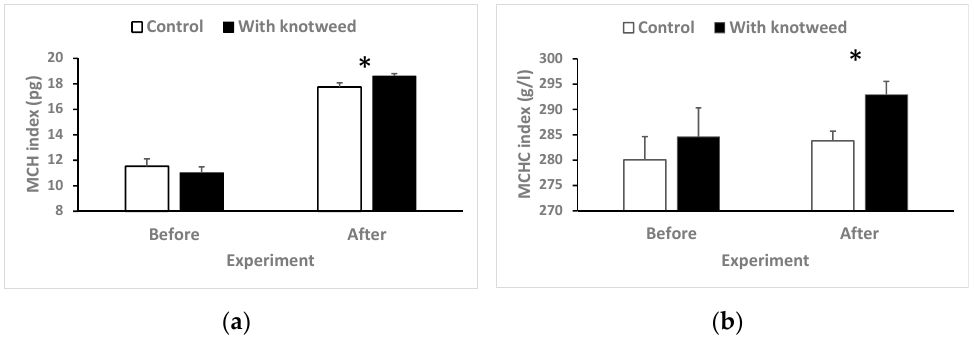
Figure 11. The MCH index ( a ) and the MCHC index ( b ) in all animals at the beginning and the end of the experiment in the experimental group of pigs fed on fodder with knotweed and the control group. Means + SEM. Difference significant on p < 0.05 marked by an asterisk.